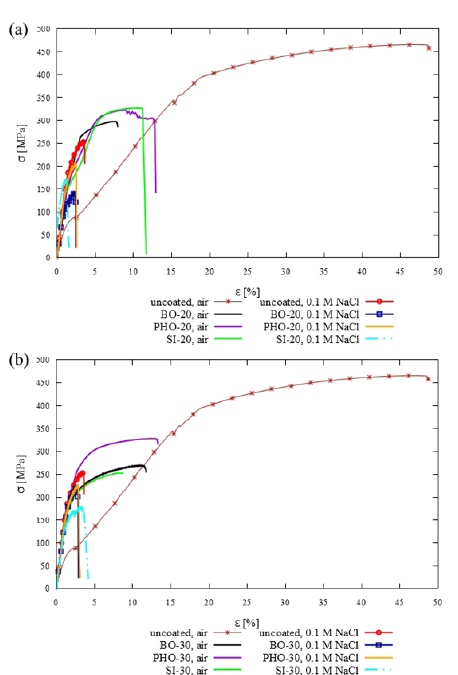
Figure 11. Engineering stress versus engineering strain curves of the uncoated and anodized AZ61 alloy in air and 0.1 M NaCl solution: a) anodization at 20 mA.cm -2 ; b) anodization at 30 mA.cm -2